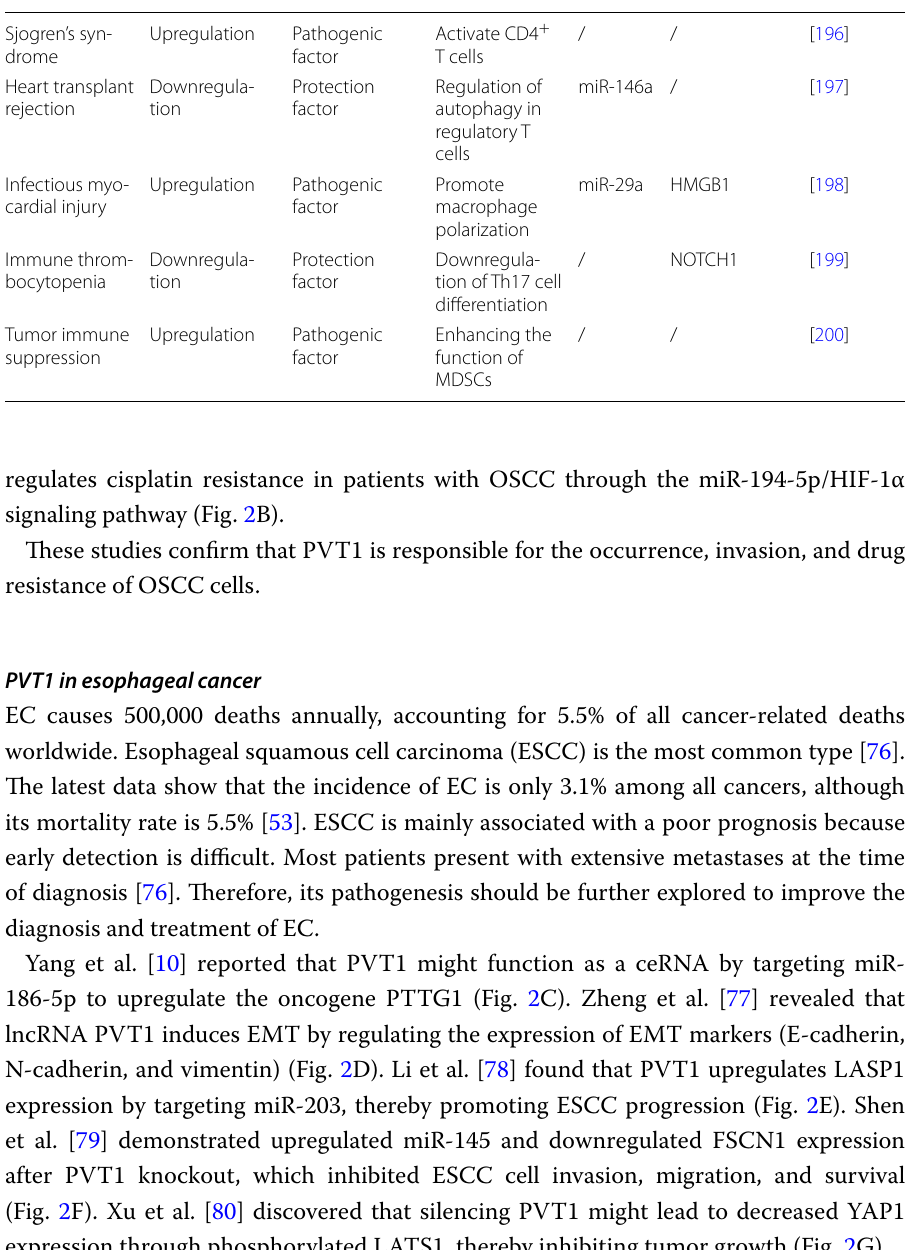
Table 9 Functional characterization of PVT1 in immune system Disease